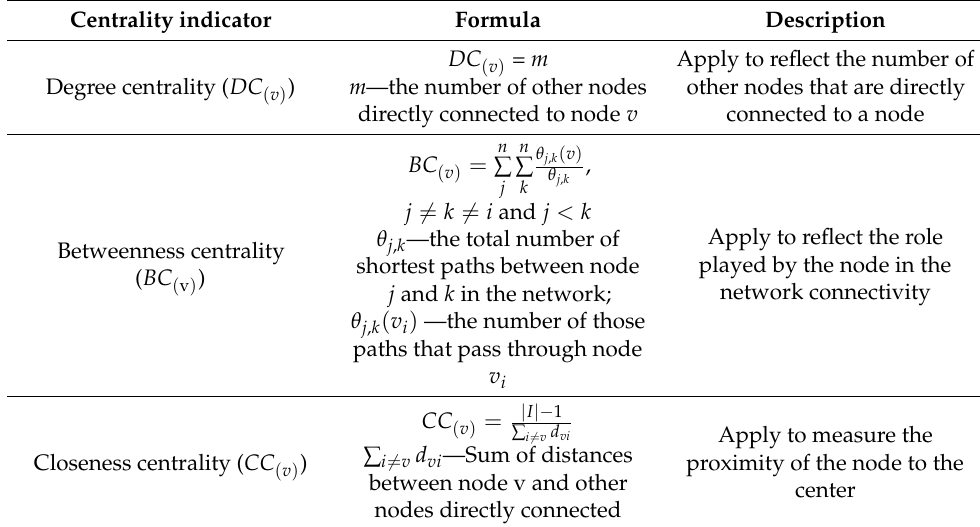
Table 4. Three centrality indicators for measuring network features of technical keywords. Centrality